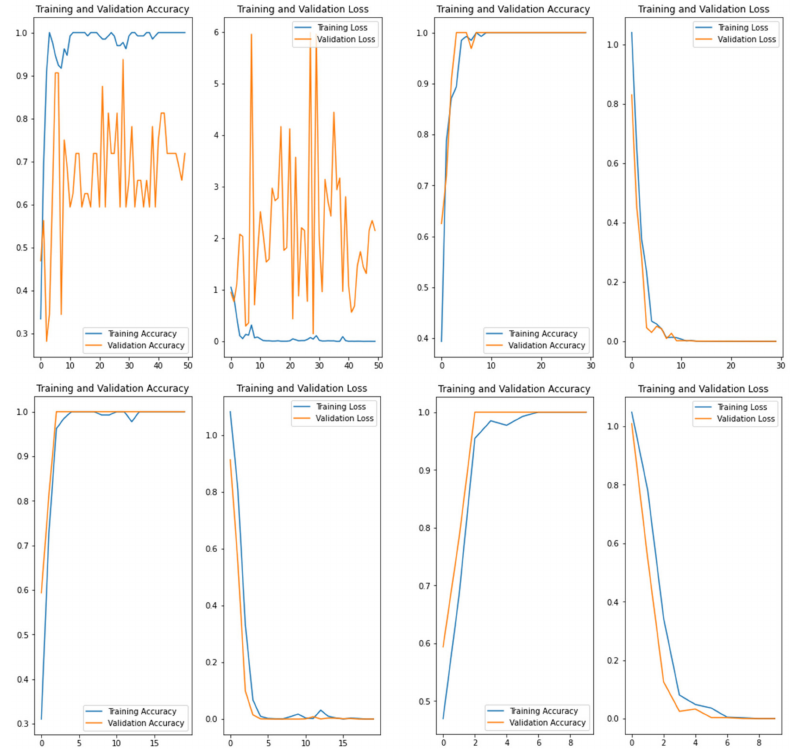
Figure 6. Illustration of model accuracy rate for 50, 30, 20, and 10 epochs for DB3 dataset acquired using a thermal sweeping sensor “FingerChip FCD4B14CB” by Atmel.